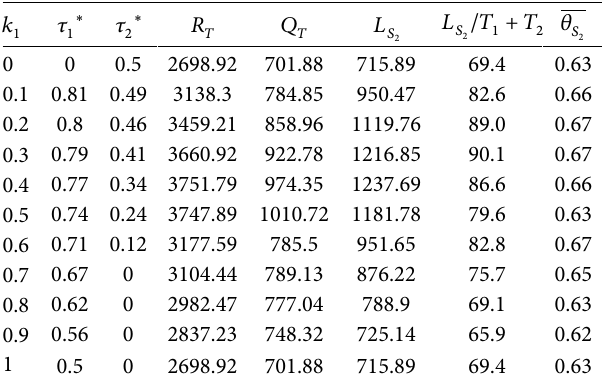
Table 4: Product sales and average freshness under basic